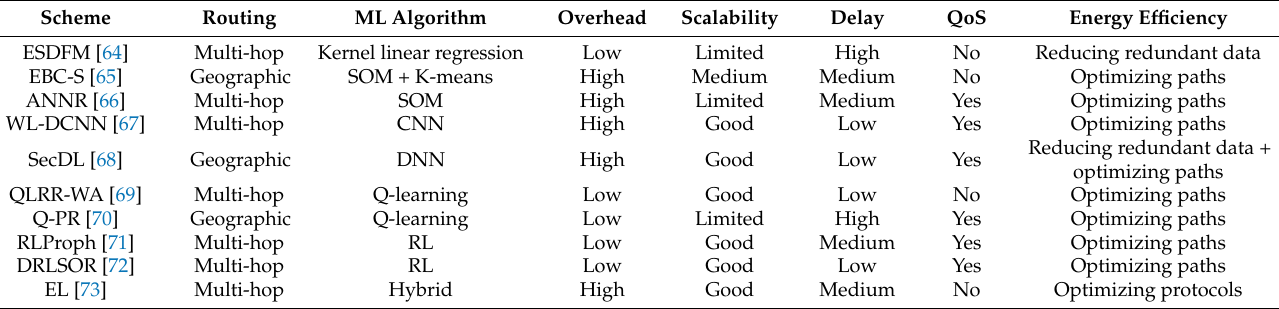
Table 4. The comparisons of ML-based routing